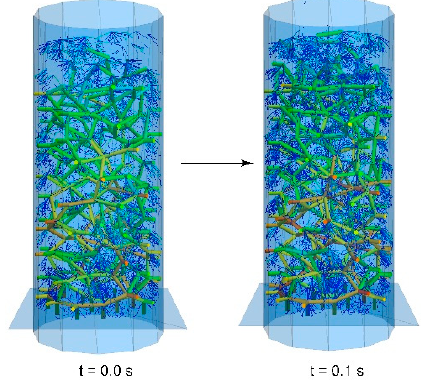
Figure 18. Evolution of model contact force when t = 0.0 s and t = 0.1 s.